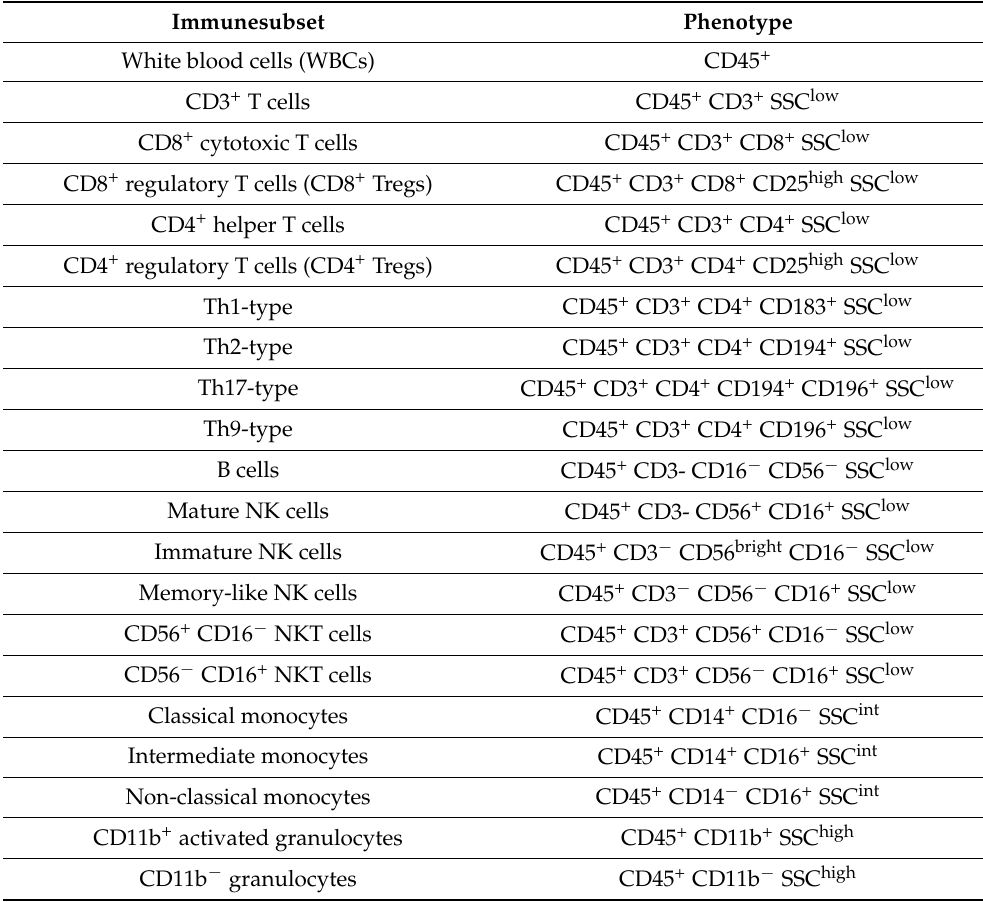
Table 2. Immune subsets analyzed and their respective